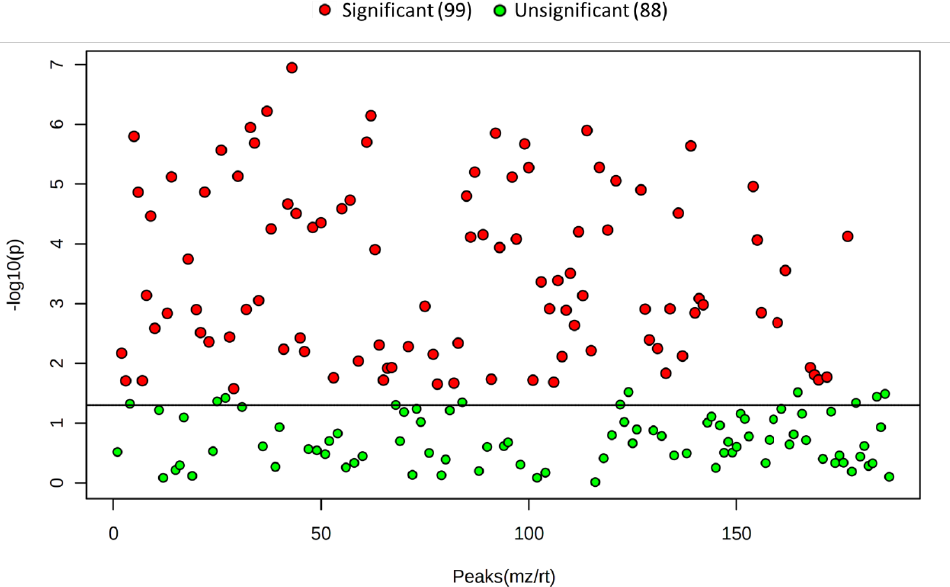
Figure 6. ANOVA scatter plot of the identified metabolites across each extraction method. Each point on the scatter plot represents one signal that matched to the in-house library of standards.